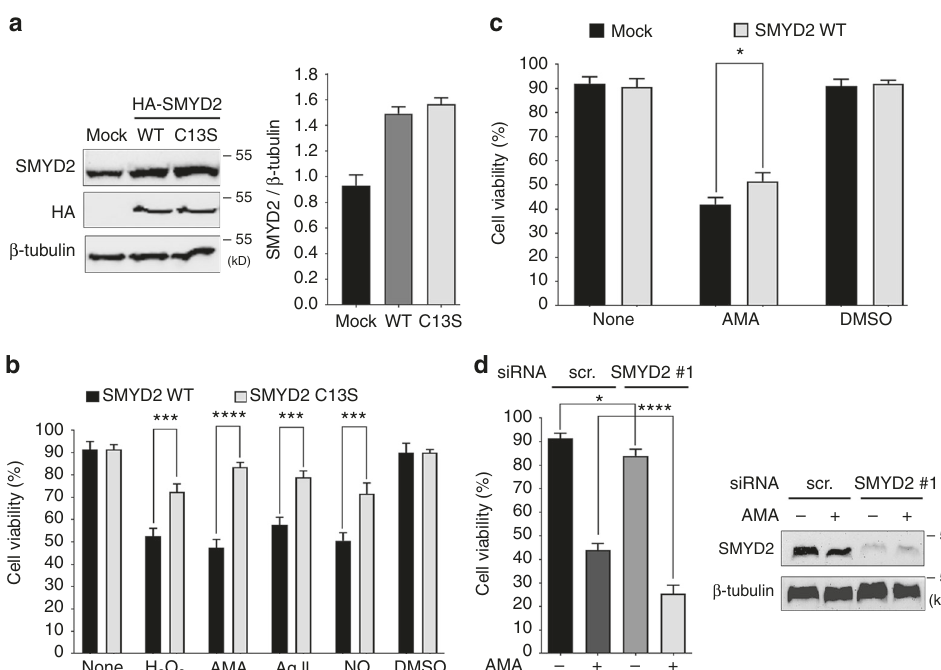
Fig. 3 SMYD2 Cys13 glutathionylation or oxidation decreases cell viability. a Levels of SMYD2 WT and C13S in differentiated H9c2 cells. b Viability of differentiated H9c2 cells expressing SMYD2 WT or C13S after exposure to H 2 O 2 (25 µ M), AMA, (2 µ g/mL), angiotensin II (Ag II, 1 µ M), or a nitric oxide (NO) donor (NONOate, 100 µ M) for 24 h. c , d Viability of differentiated H9c2 cells with overexpression ( c ) or knockdown ( d ) of SMYD2 after treatment of AMA (2 µ g/mL) for 24 h. Data represent the mean ± SD, n = 3 independent experiments. Difference is signi fi cant by two-way ANOVA followed by Bonferroni ’ s post-hoc test ( b , c ) and one-way ANOVA followed by Tukey ’ s post-hoc test ( d ), * p < 0.05, ** p < 0.01, *** p < 0.001, **** p <